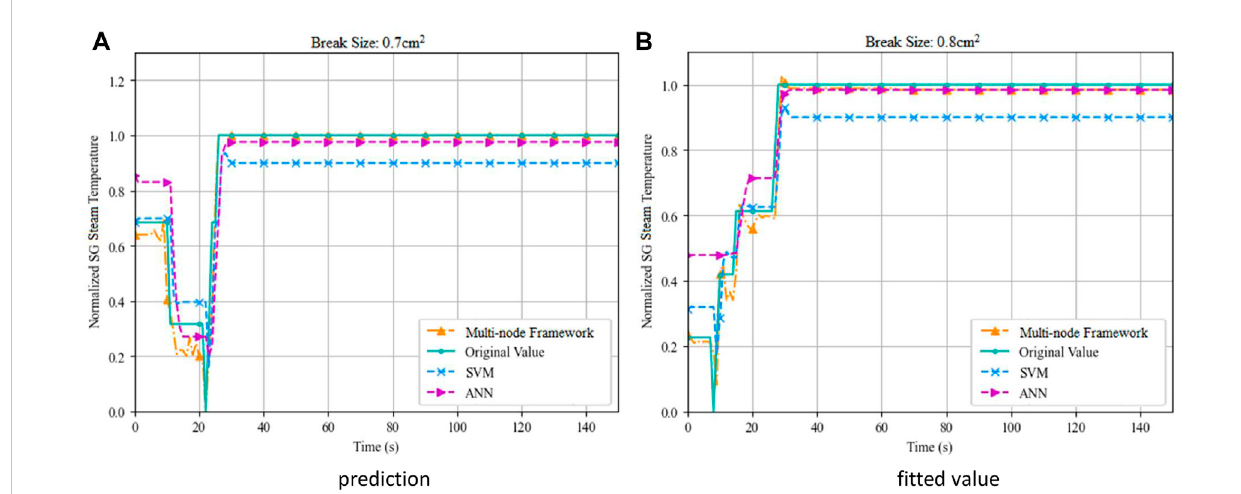
FIGURE 9 Comparison of prediction of SG steam temperature during LOCA. (A) prediction (B) fi tted value.